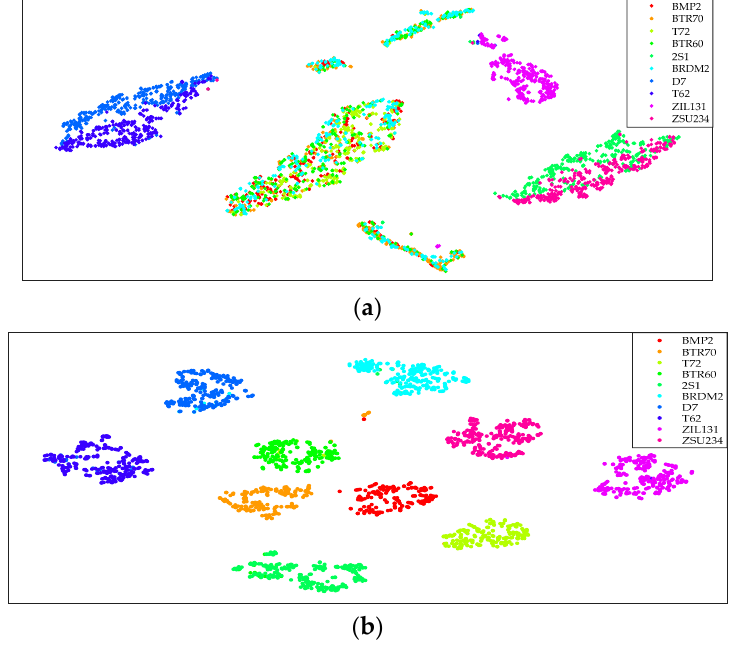
Figure 8. The distribution of cascaded features and fused features. ( a ) The distribution of cascaded features; ( b ) The distribution of the fused features in the same feature space.